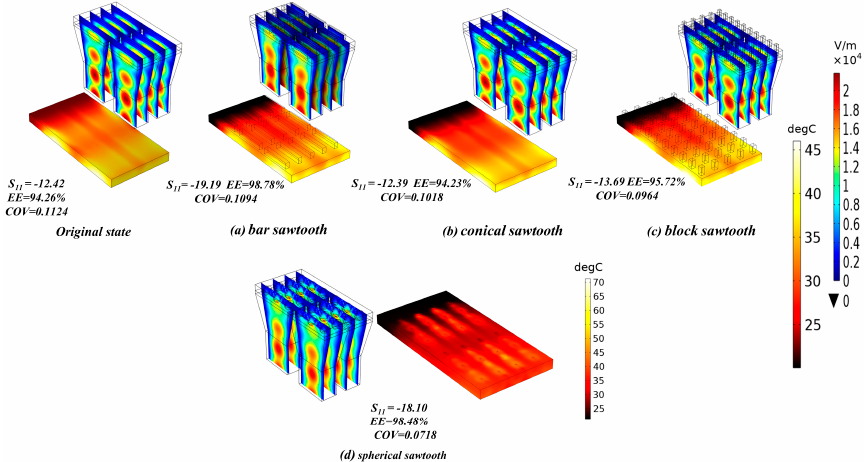
Figure 12. Electric field distribution and temperature distribution. ( a – d ) represent the case after adding each of the four sawtooth structures, and ‘original state’ represents the case before adding.